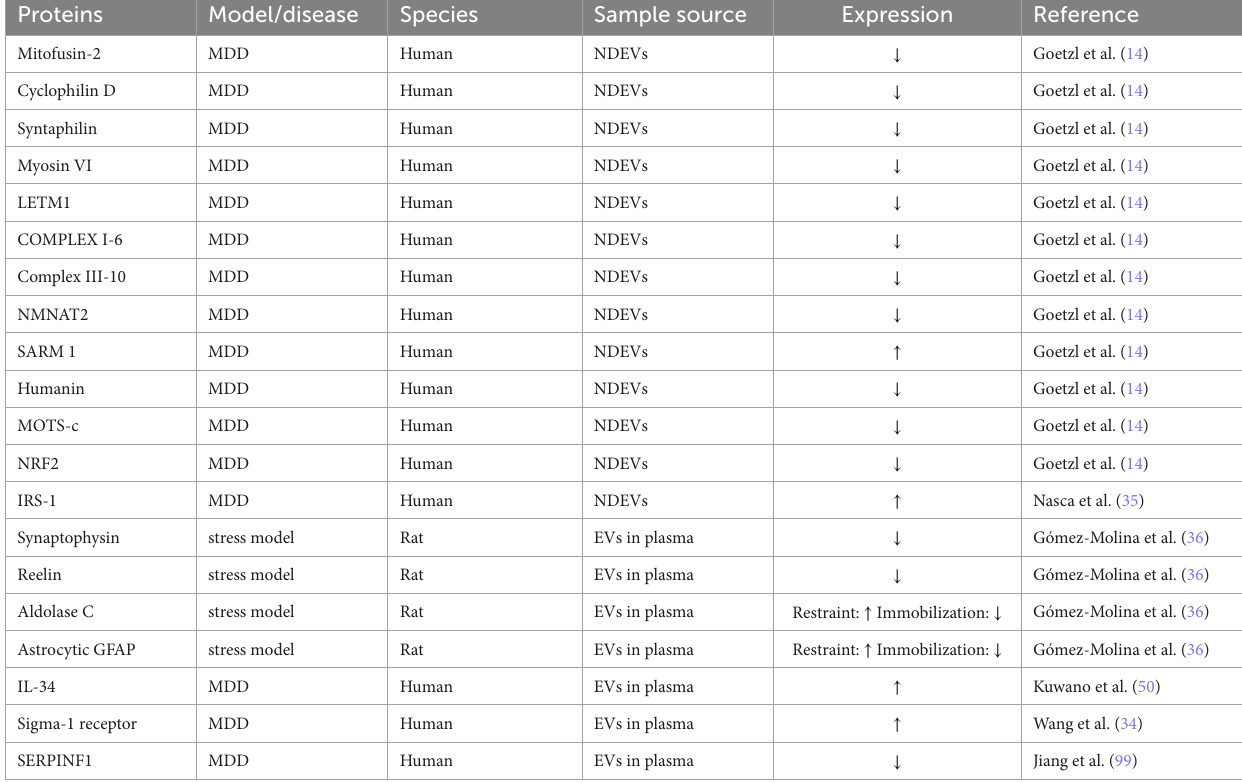
TABLE 1 Differentially expressed EVs’ proteins in MDD subjects versus matched healthy controls and stress model rats versus control group.